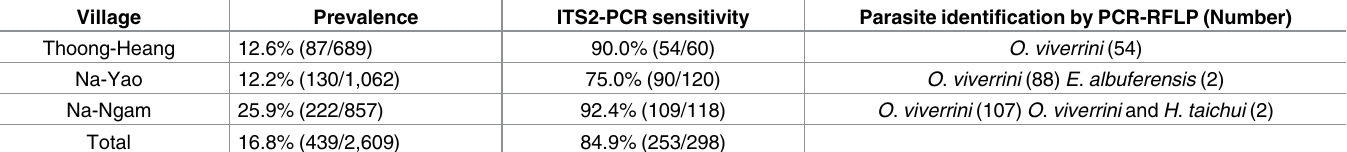
Table 1. The prevalences of Opisthorchis -like egg, ITS2-PCR sensitivities and PCR-RFLP profiles for detection Opisthorchis -like eggs in Cha- choengsao Province, central Thailand. Village